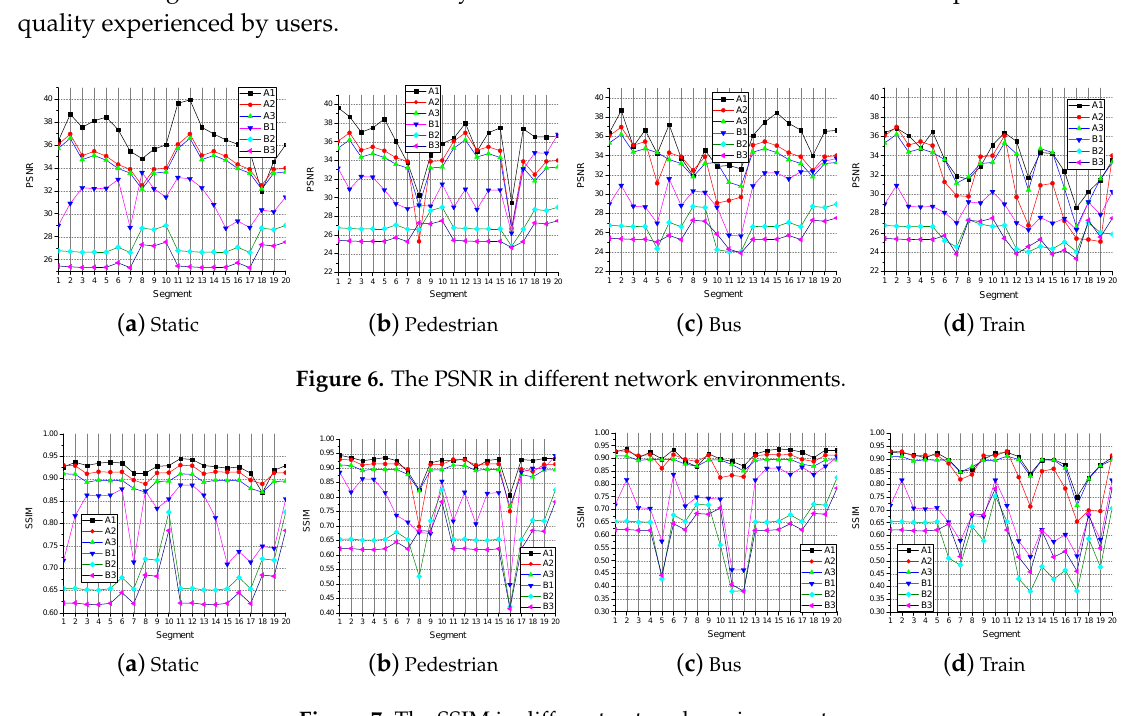
Figure 7. The SSIM in different network